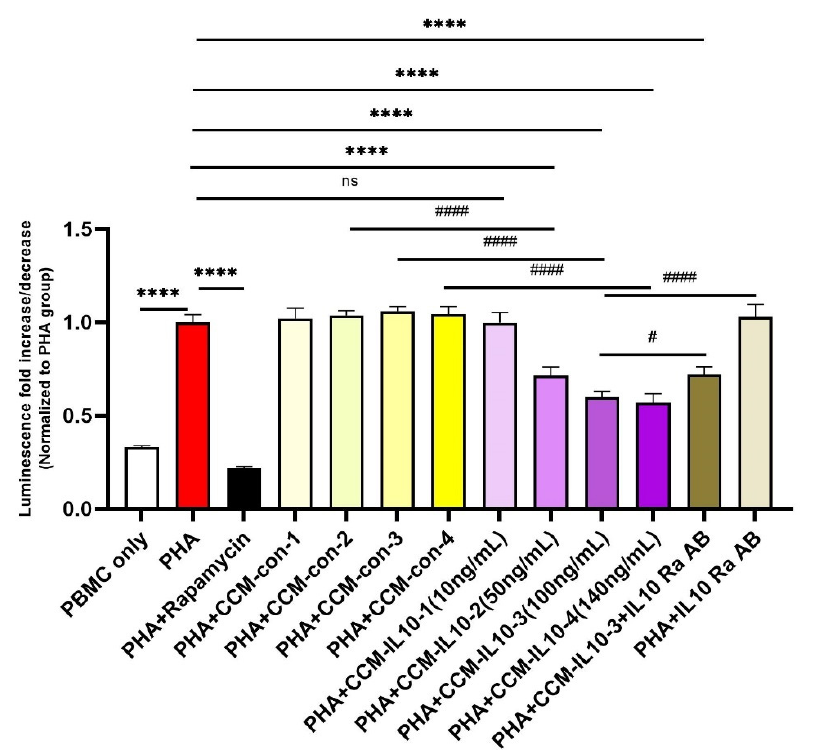
Figure 3. Immunosuppressive properties of CCM-IL10. Different concentrations of IL-10 in CCM-IL10 impact the immunosuppressive effects. PHA was used to activate T cells and induce proliferation, which can be mostly blocked by rapamycin. The immunosuppressive effects were observed using CCM-IL10 with IL-10 concentration ranging from 10 ng/mL to 140 ng/mL, while respective volumes of CCM-con did not cause significant decreases in cell viability. IL-10 receptor α antibody partly blocked the cell viability decrease induced by CCM-IL10 (100 ng/mL). Statistical differences were evaluated by one ‐ way ANOVA. Data presented as mean ± SD ( n = 4), * indicates groups compared with PHA only group, and # indicates comparisons with CCM ‐ IL10 groups. **** p < 0.0001, # p < 0.05, and ##### p < 0.001.